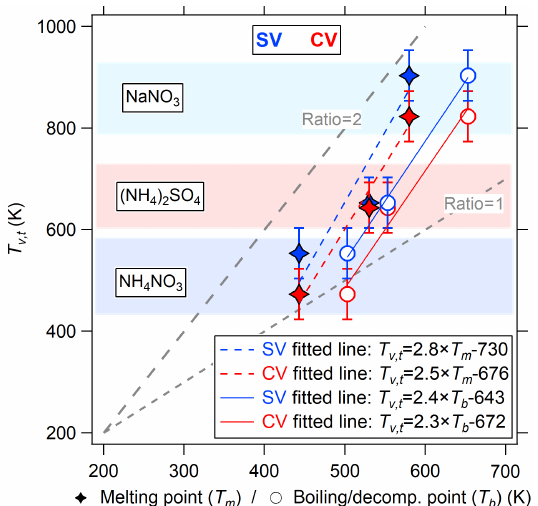
Figure 14. Scatter plot between transition T v (T v , t ) and melting points ( T m ) and boiling/decomposition points ( T b ) of three stan- dard species in both SV and CV. The boiling point of (NH 4 ) 2 SO 4 is its decomposition temperature (Haynes,